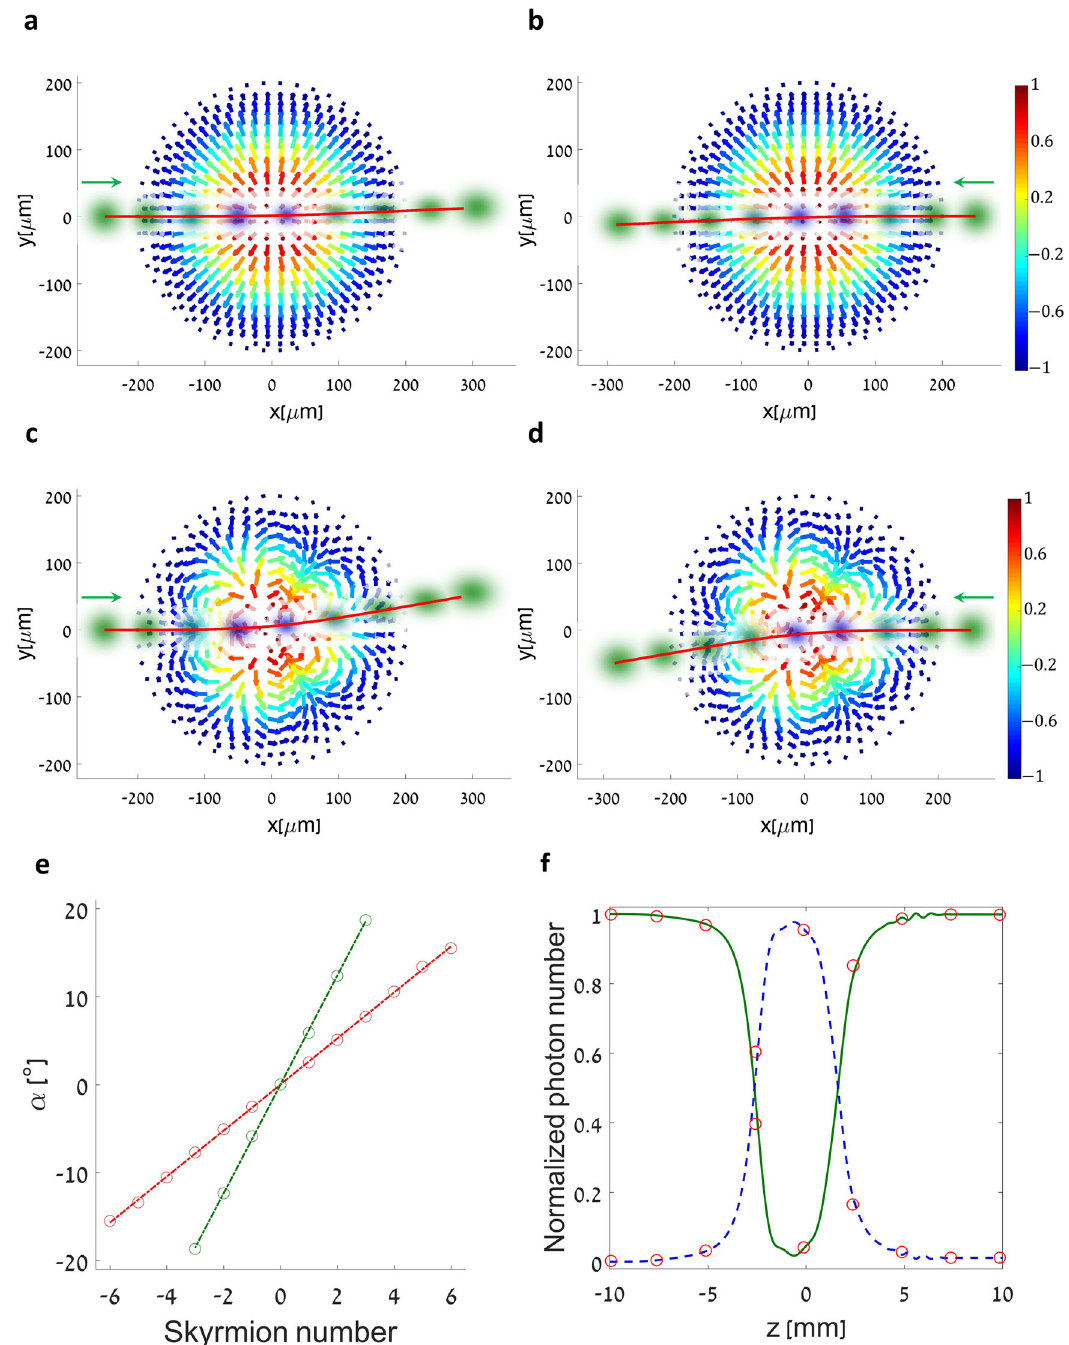
Fig. 3 Simulating the topological Hall effect in skyrmionic nonlinear photonic crystals. a, b Simulated beam shape and position in the transverse plane of the crystal, for selected depths of propagation inside the NLPC (the successive points are for z locations of (cid:2) 10 : 0 ; (cid:2) 7 : 5 ; (cid:2) 5 : 0 ; (cid:2) 2 : 5 ; 0 ; 2 : 5 ; 5 : 0 ; 7 : 5 and 10 : 0mm). The theoretical trajectory of the beam ’ s center-of-mass motion is depicted by solid red lines. In a , an idler beam enters the NLPC at an entrance (cid:4) (cid:5) ¼ cos ð πρ = R Þ ; n ¼ 1 ; η ¼ 0 ; R ¼ 200 μ m) from left to right. Also inset is the angle of 1.5 degrees, traversing a Néel-type antiskyrmion ( S ¼ (cid:2) 1, m ρ transverse component of the synthetic magnetization in the NLPC, color-coded by its corresponding z -component. In b , the dynamics are fl ipped (from right to left), and as a result, the beam is de fl ected in the opposite direction — a clear signature of the THE. c , d Same as in a , b , but with an engineered high- order antiskyrmion ð n ¼ 4 Þ , causing a more pronounced difference in the de fl ection. e De fl ection angle of the beam for varying skyrmion numbers. By considering the rotation of the velocity vector v by the magnetic fi eld, the de fl ection angle of the beam ’ s center-of-mass should be α / S = R v j j (see Supplementary Material). Simulation results show a clear linear dependence on the skyrmion number, for two different cases (red circles — R ¼ 200 μ m, v j j ¼ sin 1 : 5 (cid:3) ð Þ ; green circles - R ¼ 100 μ m and v j j ¼ sin 1 : 2 (cid:3) ð Þ ). f Photon number, normalized by its initial value, in the idler (green continuous line) and signal (blue dashed line) frequencies as a function of the propagation inside the NLPC for case a , demonstrating adiabatic frequency conversion. Full simulation parameters are given in the Methods.